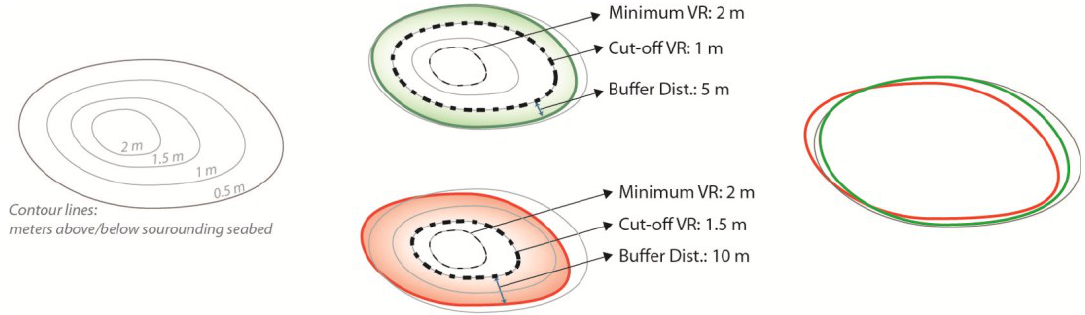
Figure 7. Example of the delineated outline depending on the choice of the different values of Cutoff Vertical Relief (cut-off VR) and Buffer Distance. Note that the green outline better represents the pockmarks’ limits than the red outline.